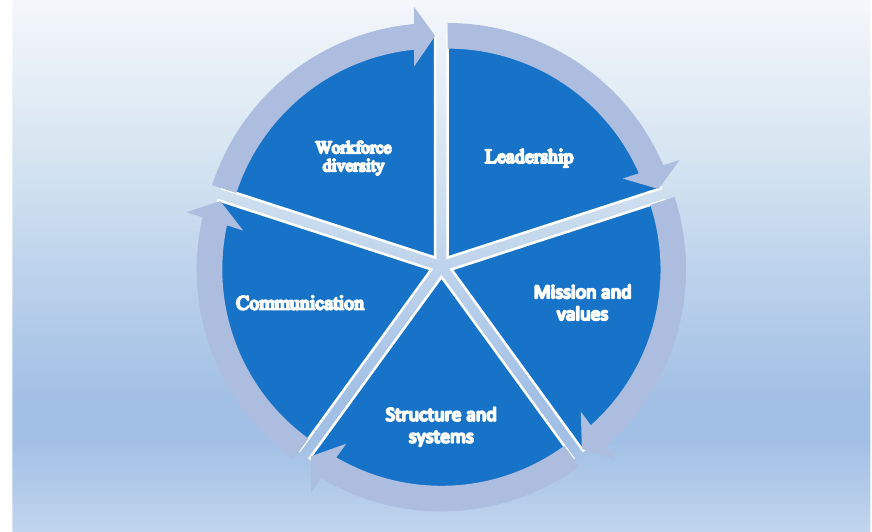
Figure 3. Determinants of Organizational Culture. Figure created by the author.